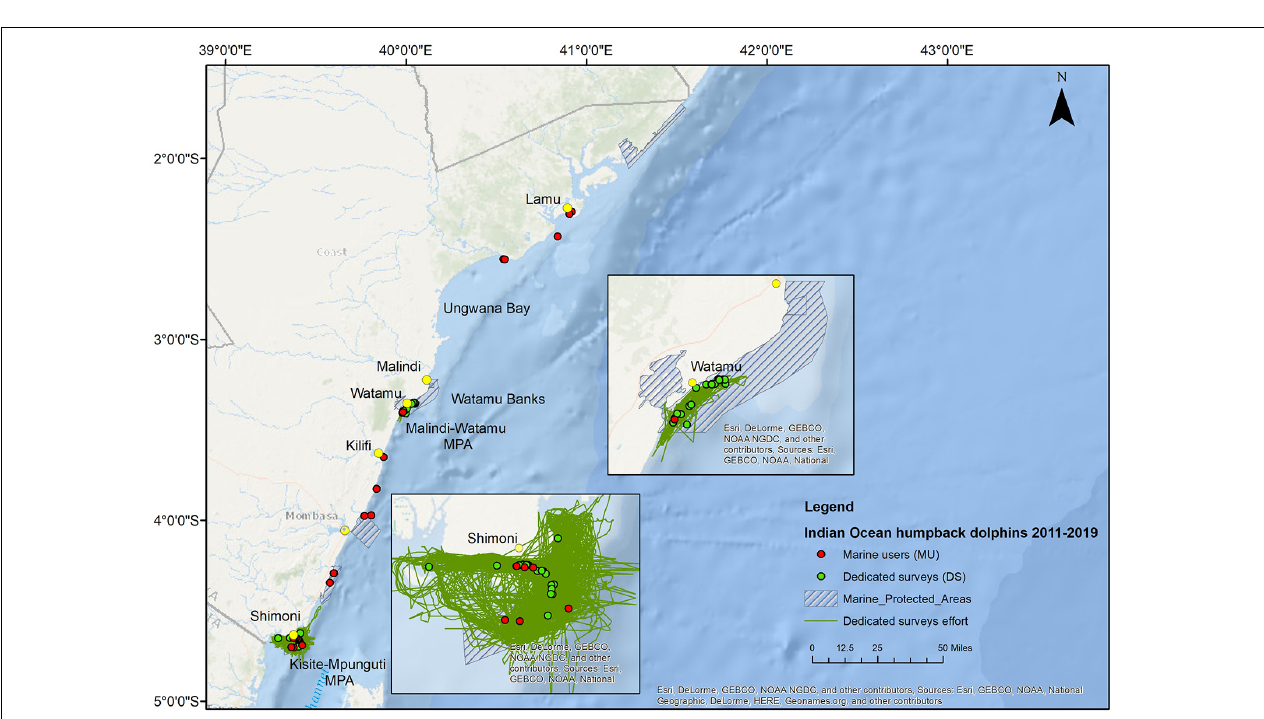
FIGURE 6 | Map showing the distribution of Indo-Pacific bottlenose dolphin sightings between 2011 and 2019 along the Kenyan coast. The boxes in the map show the areas with the highest number of reports, Kisite-Mpunguti Marine Protected Area (southern Kenya) and Malindi-Watamu Marine Protected Area (central Kenya).